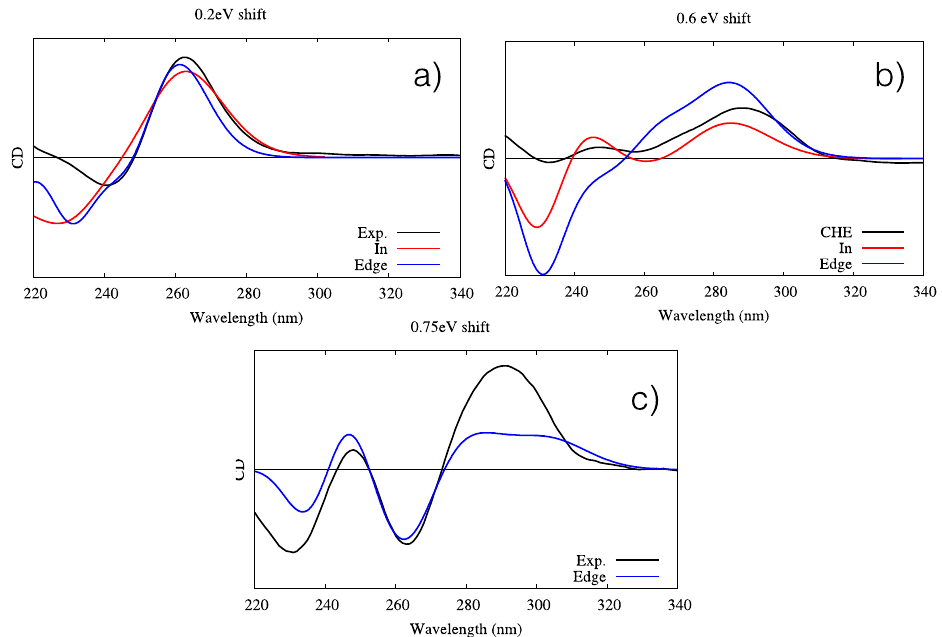
Figure 6. Experimental and simulated ECD spectra of the three G4–CHE complexes. Intensities are given in arbitrary units. ( a ) Parallel conformation, including the experimental (black line) and simulated “in” (red line) and “edge” (blue line) orientations; a shift of 0.2 eV has been applied. ( b ) Hybrid conformation, including the experimental (black line) and simulated “in” (red line) and “edge” (blue line) orientations; a shift of 0.6 eV has been applied. ( c ) Antiparallel conformation, including the experimental (black line) and simulated “edge” orientations (blue line); a shift of 0.75 eV has